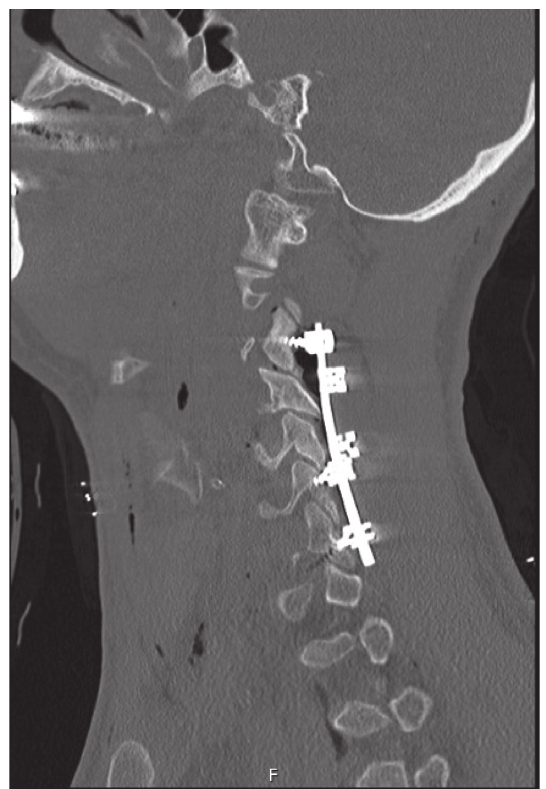
Figure 3: Computerized tomography image after surgical treat- ment via a posterior